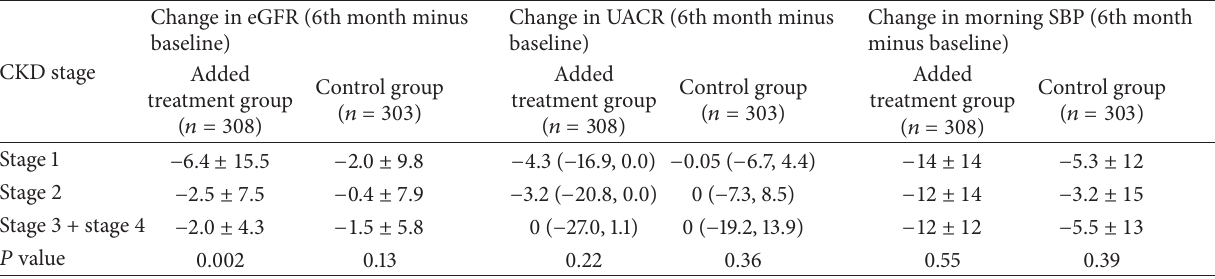
Table 5: Change in eGFR, UACR and morning SBP at each CKD